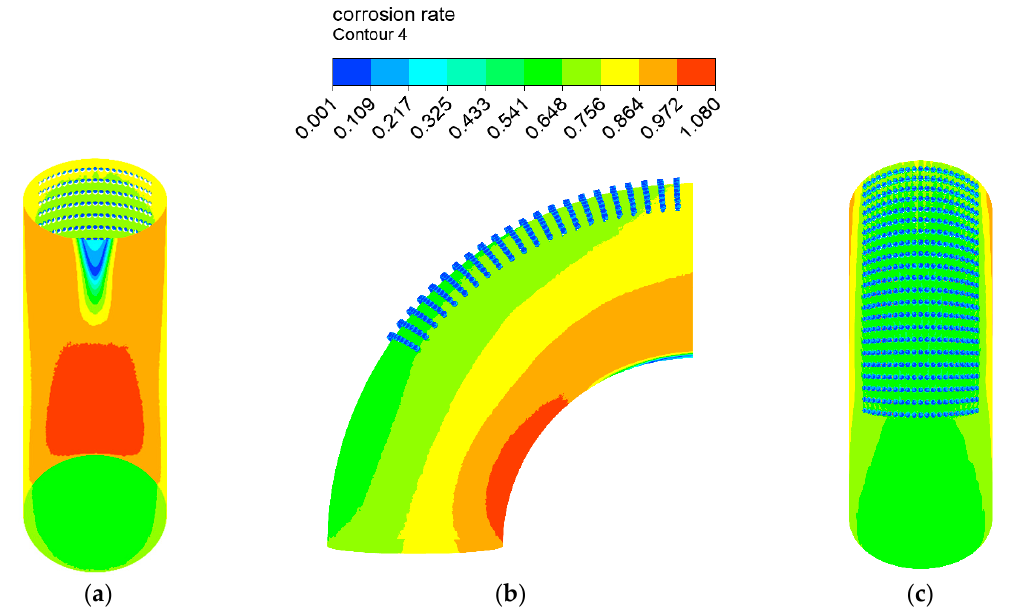
Figure 21. Distribution of the corrosion rate: ( a ) view from +Y; ( b ) view from +X; ( c ) view from − Y.